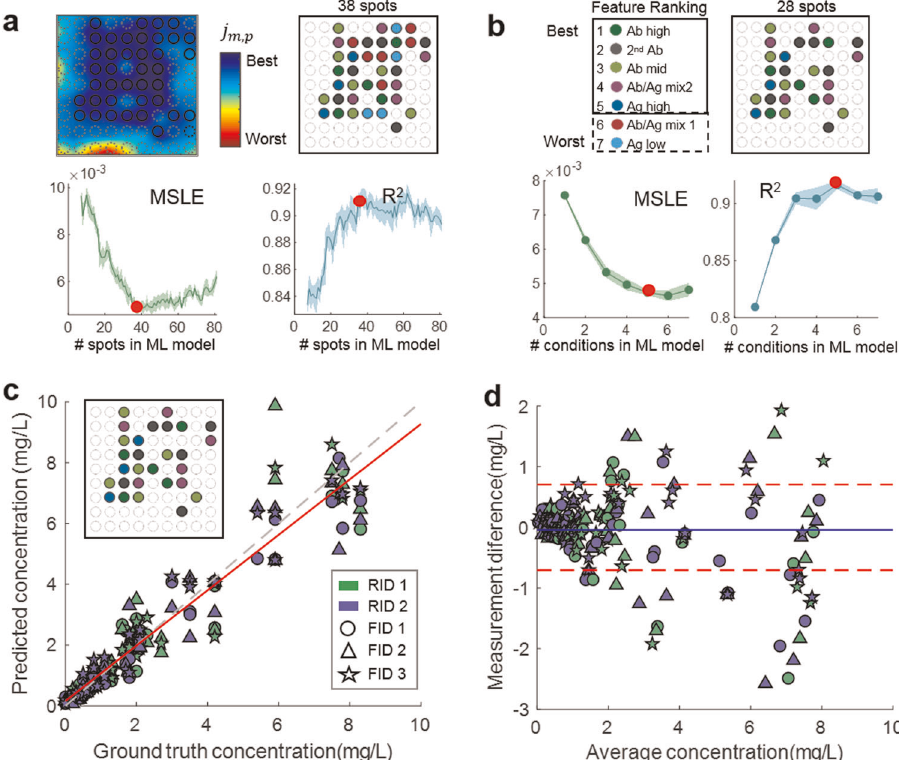
Fig. 2 Cross-validation and feature selection analysis using the training data set of clinical samples ( N train = 209). a The spot selection process. A heat-map (top left) is generated by plotting the cost function j m ; p across the sensing membrane. The cross-validation performance, both MSLE and the coef fi cient of determination ( R 2 ), is then plotted against the number of spots selected based on j m ; p (bottom). The optimal subset of spots (top right) is then selected based off the optimal quanti fi cation performance indicated by the solid red marker. b The condition selection process. Conditions are ranked based on an iterative elimination method (top left), and the cross-validation performance is plotted against the number of conditions input into the quanti fi cation network. The optimal subset of conditions (top right) is then selected based off the optimal quanti fi cation performance indicated by the solid red marker. c The cross validation results using the selected features, where the ground truth CRP concentration is plotted against the predicted CRP concentration. The marker color and shape represent the different reagent batch ID (RID) and the fabrication batch ID (FID), respectively. d Bland-Altman plot of the same cross-validation results, where the dashed red lines represent the ± standard deviation of the measurement difference from the tested